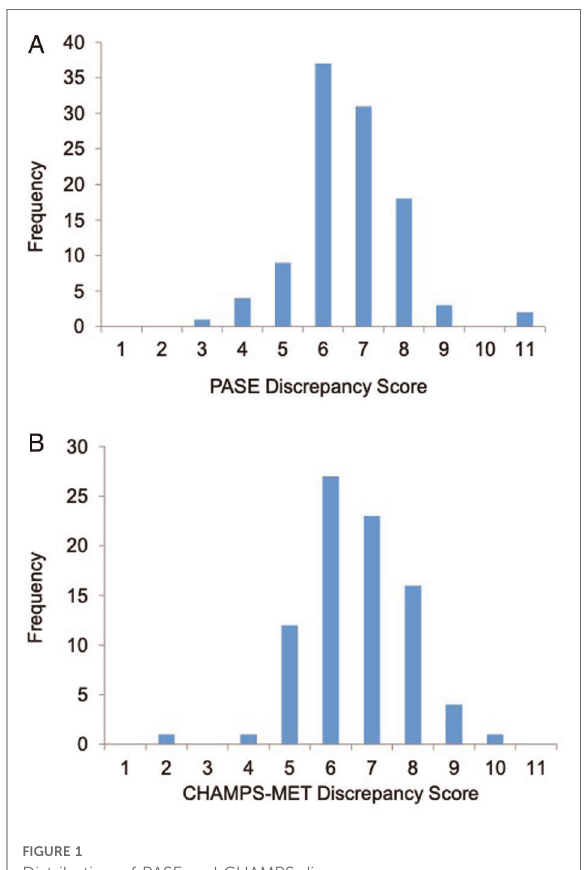
FIGURE 1 Distribution of PASE and CHAMPS discrepancy scores.